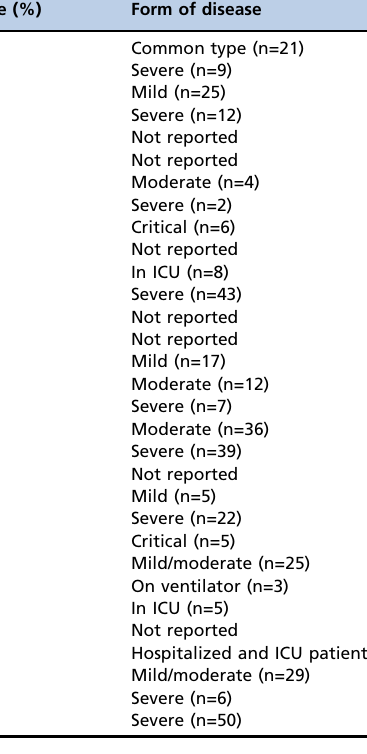
Table 3 - Summary of studies using rRT-PCR to detect SARS-CoV-2 in ocular samples from patients with COVID-19.